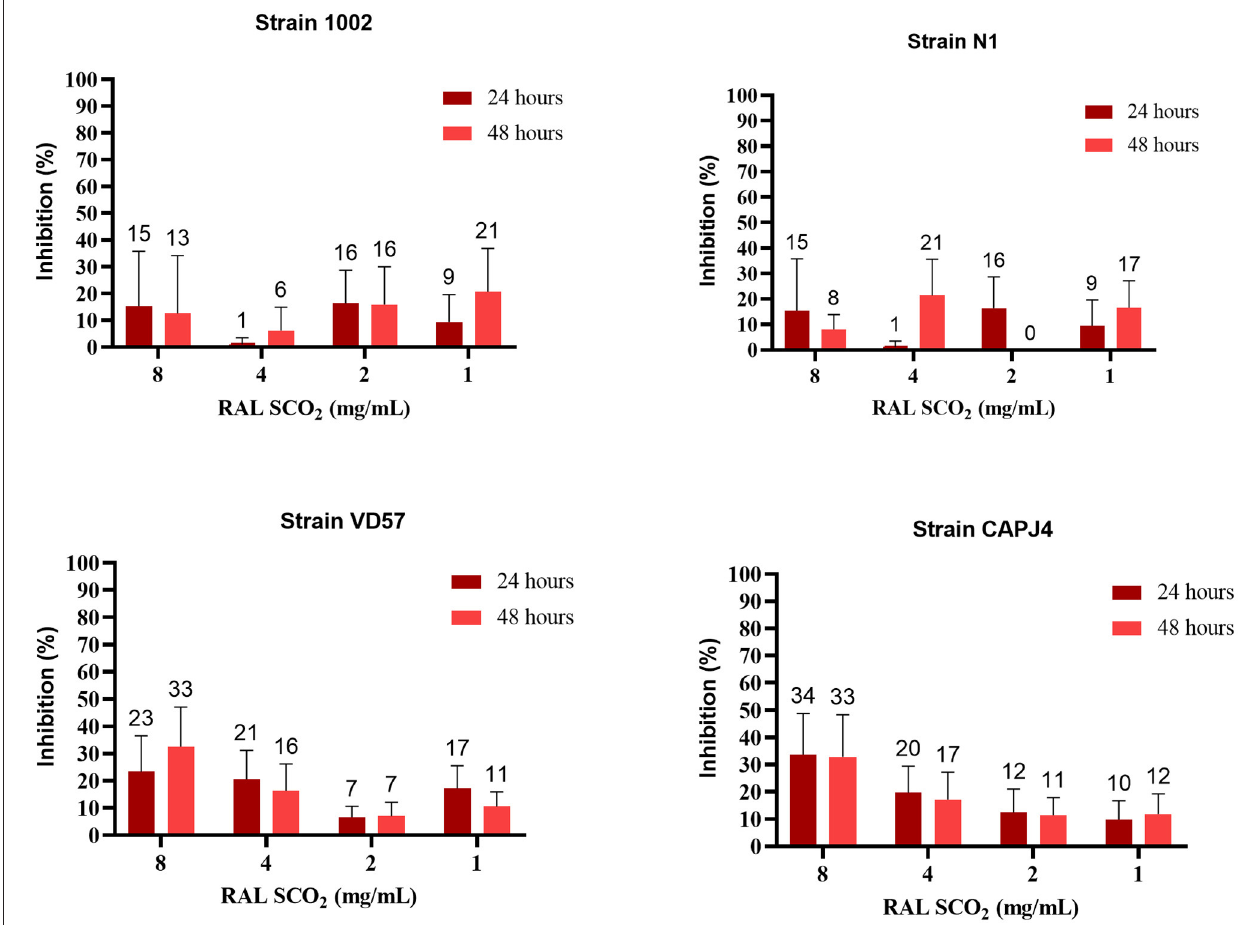
FIGURE 3 | Antibiofilm activity of the supercritical extract of red propolis (RAL SCO 2 ) in the consolidated biofilm of C. pseudotuberculosis : Strain 1002, Strain N1, Strain VD57, Strain CAPJ4. The bars represent the standard deviation of three different experiments. The values above the bars represent the average value of consolidated biofilm disruption (%). The asterisks indicate statistical differences between the bacterial cells treated with different concentrations of propolis extracts and at different times, analyzed by the one-way ANOVA and t- tests. No significant differences were found ( p < 0.05) when comparing different concentrations of propolis extracts in different incubation periods.